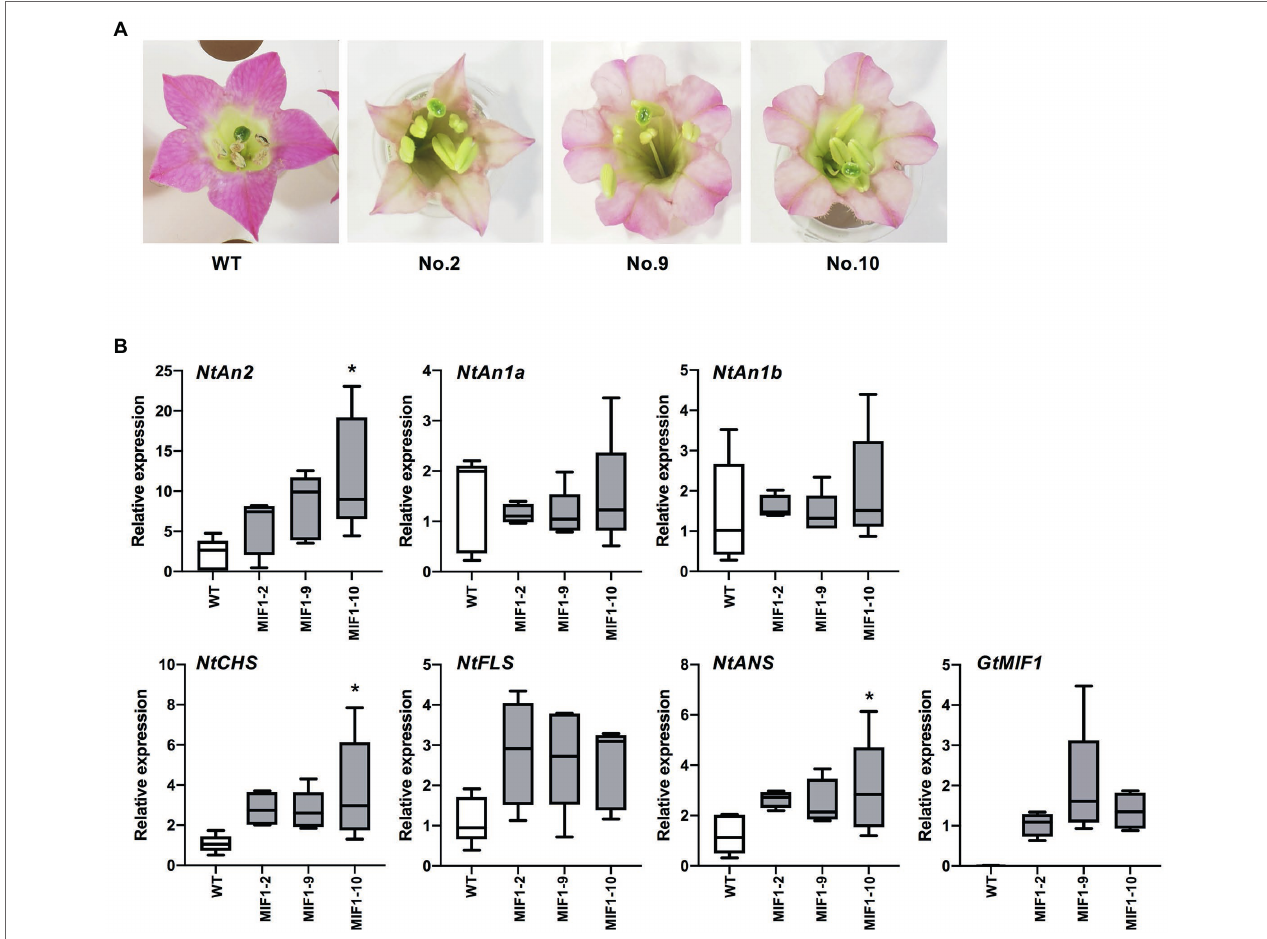
FIGURE 5 | Transgenic tobacco plants overexpressing GtMIF1 . (A) Typical flowers of WT and three T 2 lines. (B) qRT-PCR analysis of flavonoid biosynthesis-related genes in petals. Relative expression levels are shown using tobacco UBQ gene as an internal reference. * Indicates a significant difference between the expression levels of GtMIF1 -ox lines and those of WT (Welch’s t -test at * p <